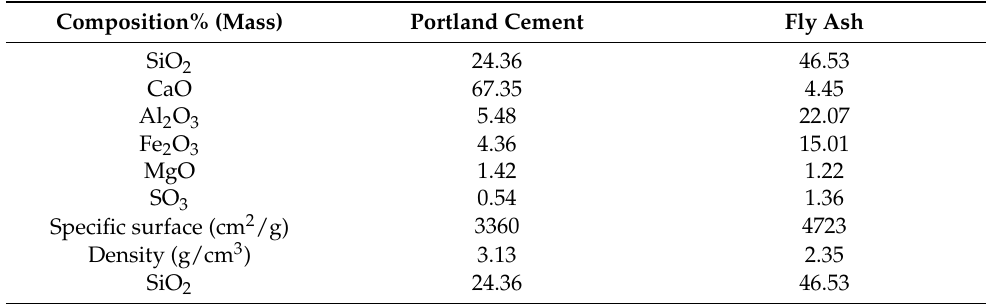
Table 1. Chemical components and physical characteristics of cementing